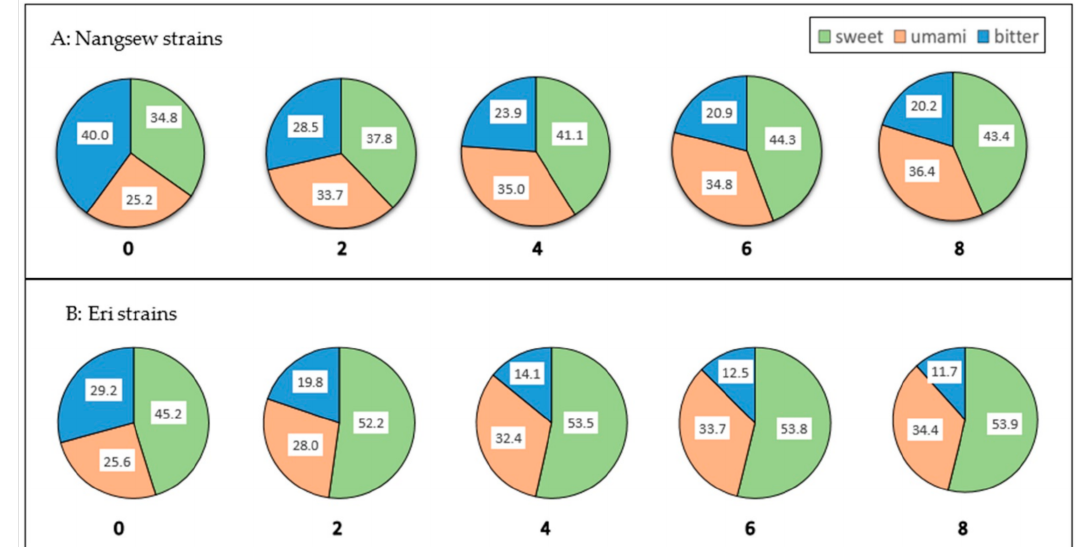
Figure 1. The effect of extraction time (hours) on the contribution of amino acids to the taste of SPE. (Sweet tastes come from alanine, glycine and serine. Umami taste comes from glutamic acid and aspartic acid. Bitter tastes come from arginine, phenylalanine, histidine, valine, tryptophan, isoleucine and leucine.).